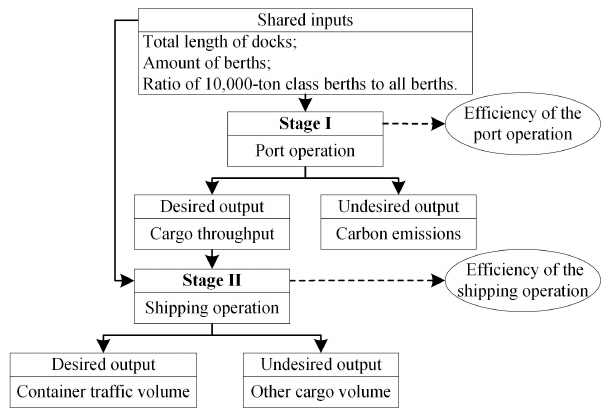
Figure 1. A two ‐ stage data envelopment analysis (DEA) model for evaluating the port’s sustaina ‐ Figure 1. A two-stage data envelopment analysis (DEA) model for evaluating the port’s sustainable ble development capability (SDC). development capability